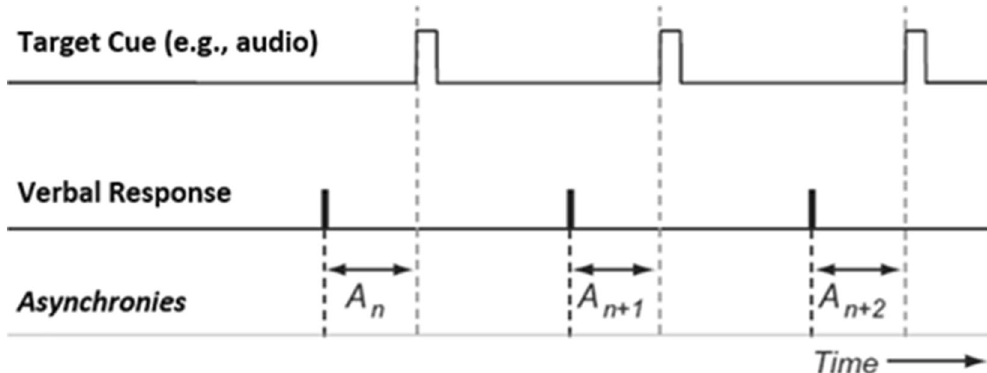
Figure 5. An illustration of the asynchrony calculation. Asynchrony is calculated as the difference between the event time of the respondent and the closest event time from the cue. Note, absolute asynchronies were used for the present